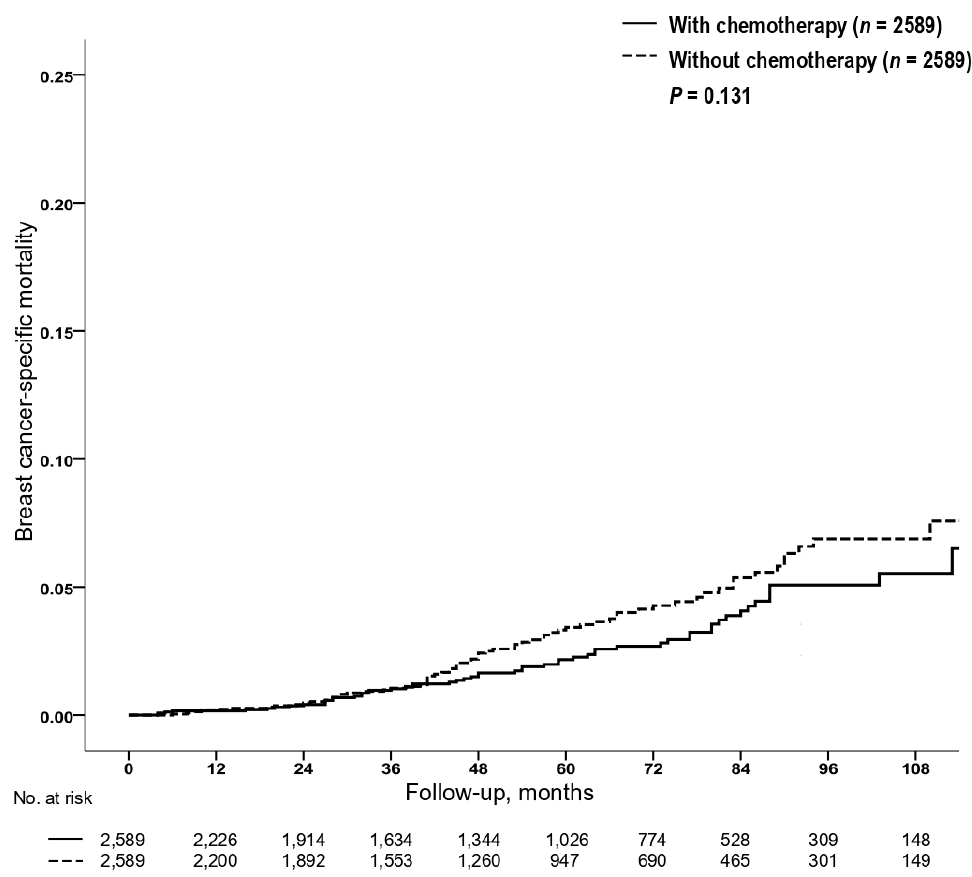
Figure 2. The Kaplan–Meier estimates of the risk of BC death according to chemotherapy in the RS 26–30 group. Abbreviations: BC, breast cancer; RS, recurrence